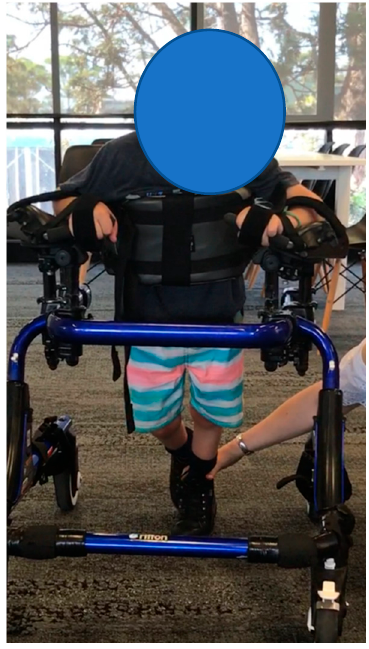
Figure 10. Participant 8.